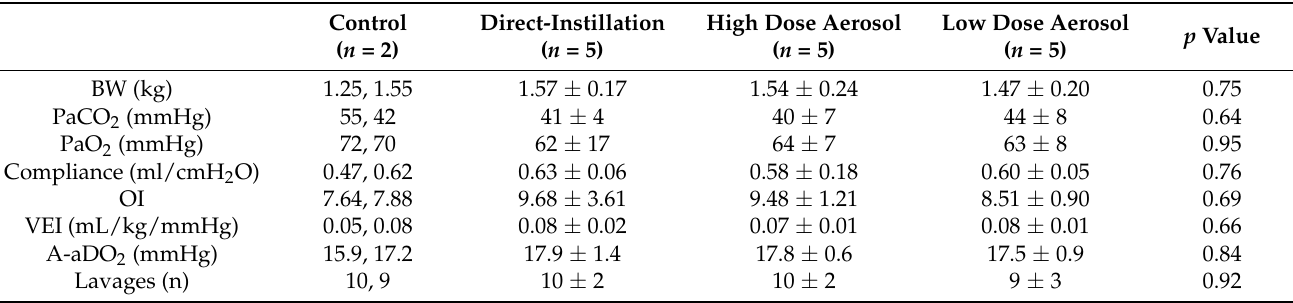
Table 1. Post-lavage Baseline